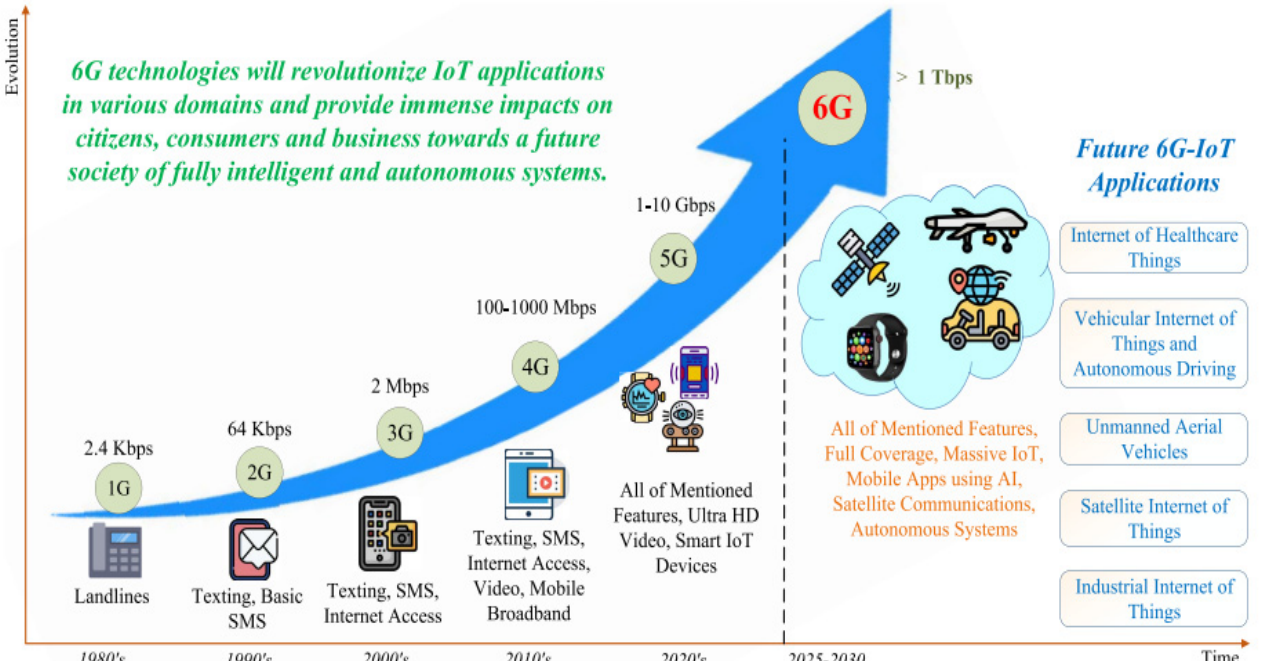
Figure 1. Phases in the development of networking technology source [9].